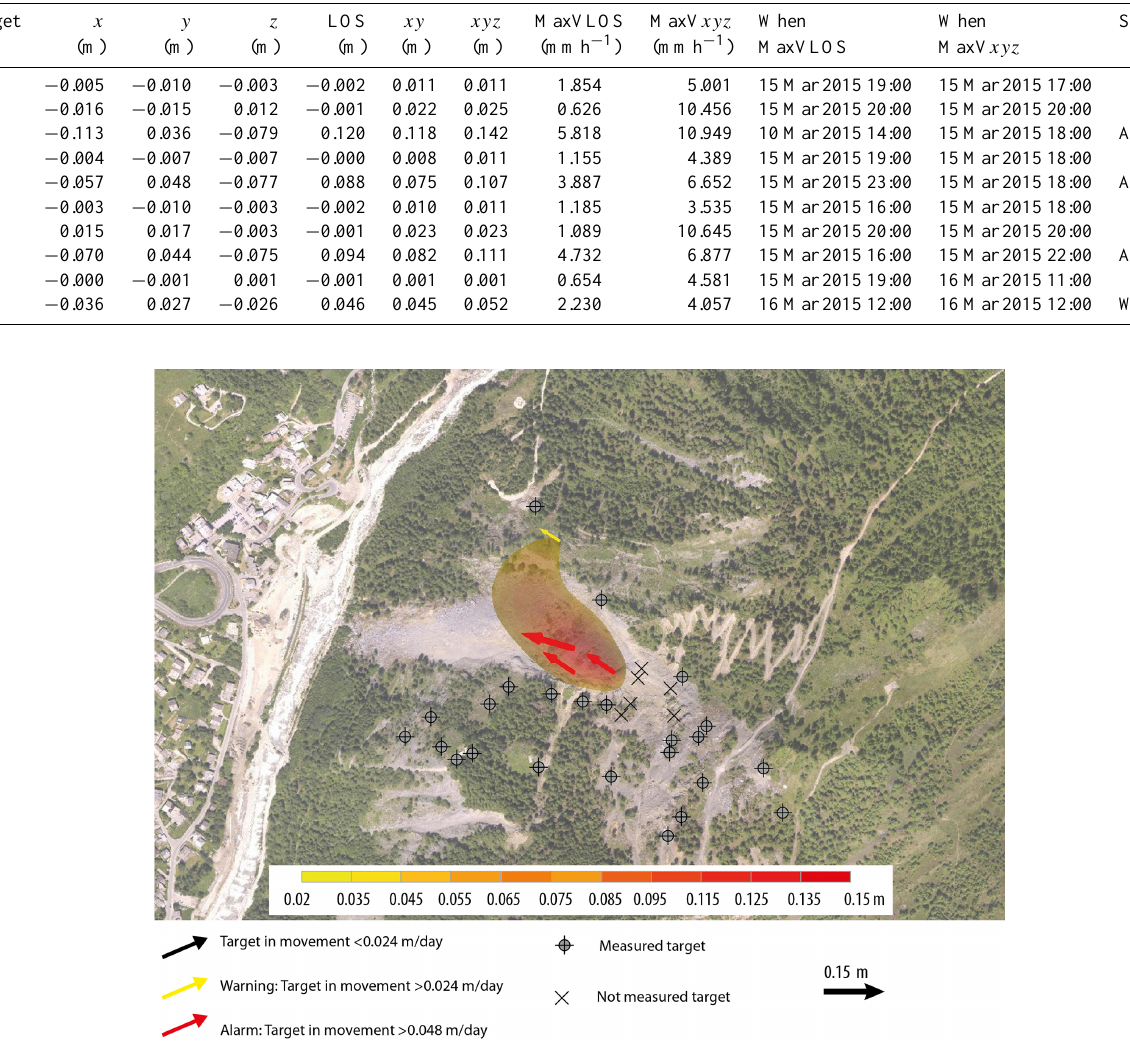
Figure 3. Example of rendering of the RTS data set dedicated to ROLE-1 related to a 24h period between 15–16 March 2015. The RTS data set is published on a 3-D representation that evidence the most active landslide sector. This map is updated in near-real time by